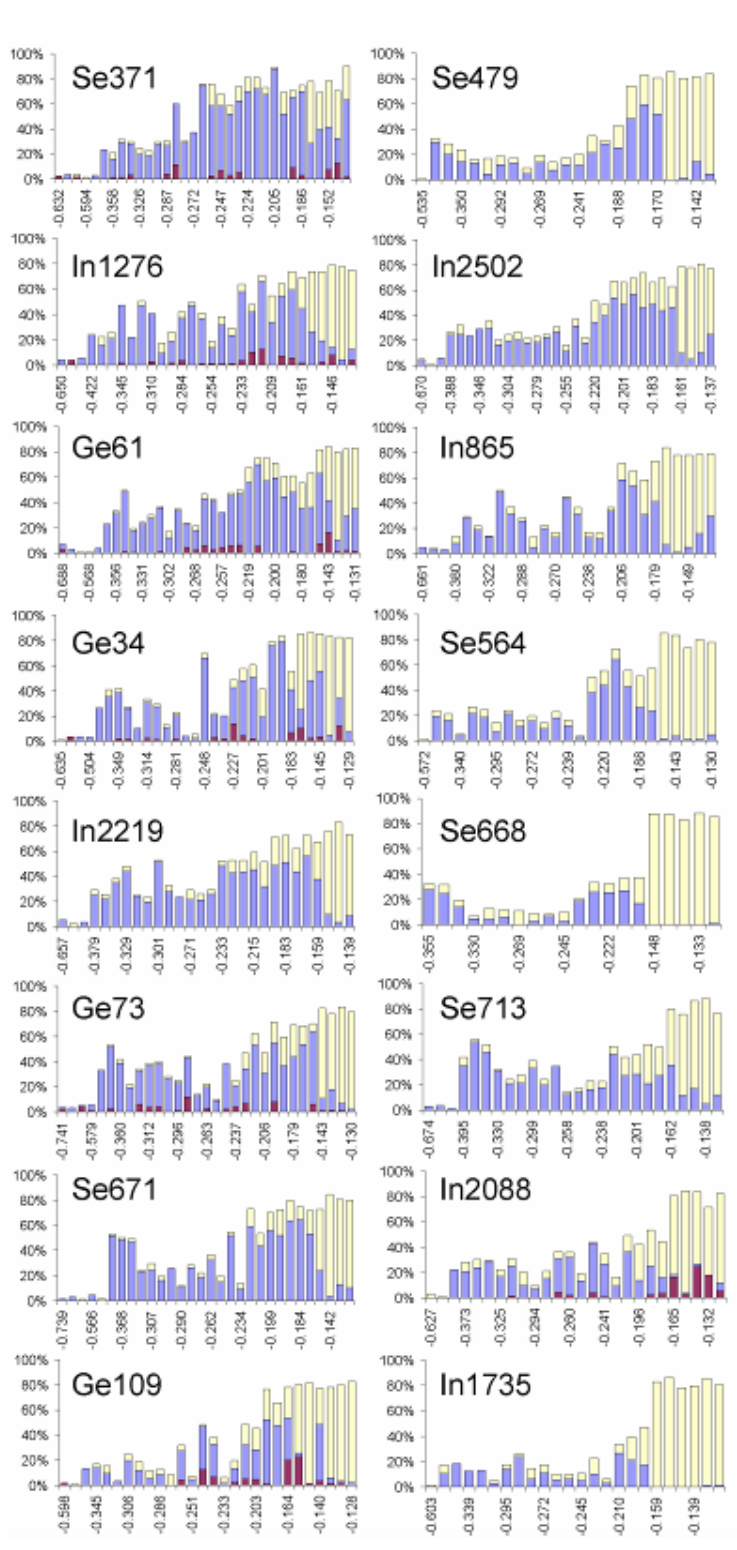
Figure 7. Atomic orbital t 1u contributions as a percentage of total molecular orbital density for the most representative clusters under study. Color notation is as follows: Ge, dark red; Se, light blue; and In, light